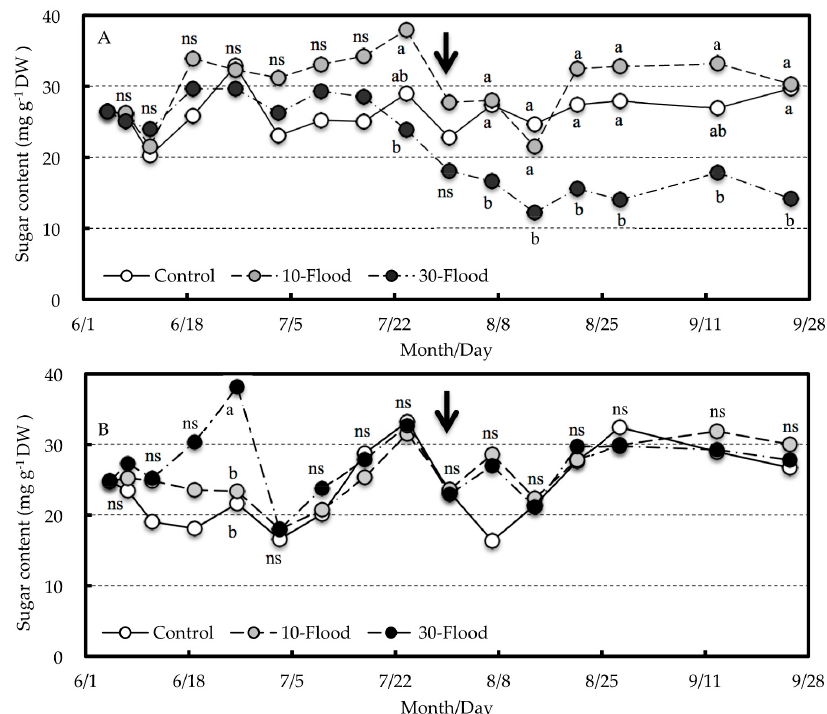
Figure 2. Changes in sugar content of roots in mango grafted trees ( A ) and seedlings ( B ) during and after treatments. Different letters in the figures indicate significant differences at p = 0.05 by Fisher’s LSD, and ns indicates no significant difference among the treatments ( n = 5). Arrow indicates the end of the treatments.